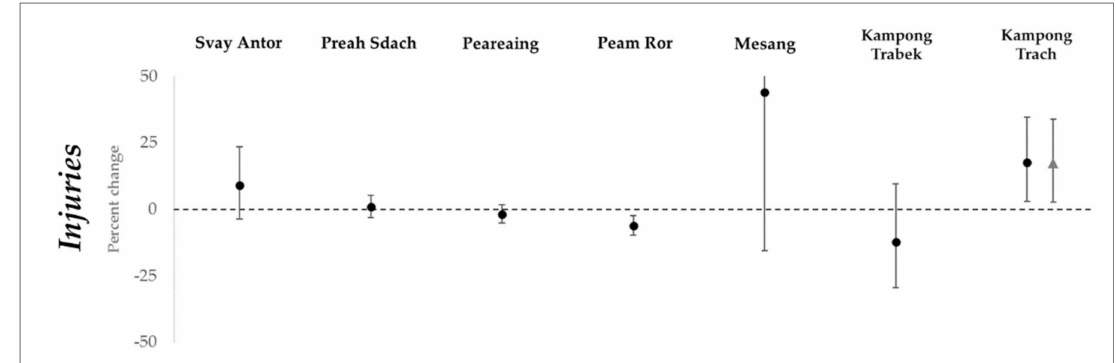
Figure 6. Percent change with 95% confidence interval in incidence rates of injuries for every ten square kilometers of flood water, in selected districts. Points marked with a circle are estimates using non-imputed data. Points marked with a triangle are estimates using imputed